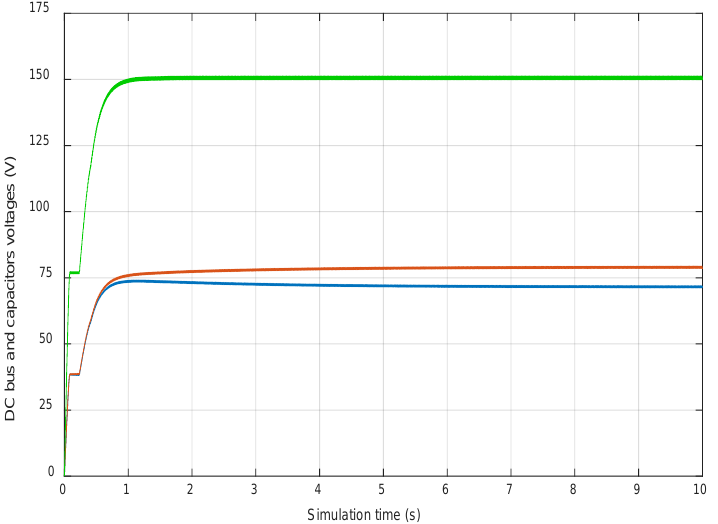
Figure 7. DC-link voltage evolution (the green curve) and capacitors voltages evolution (the red and blue curves).